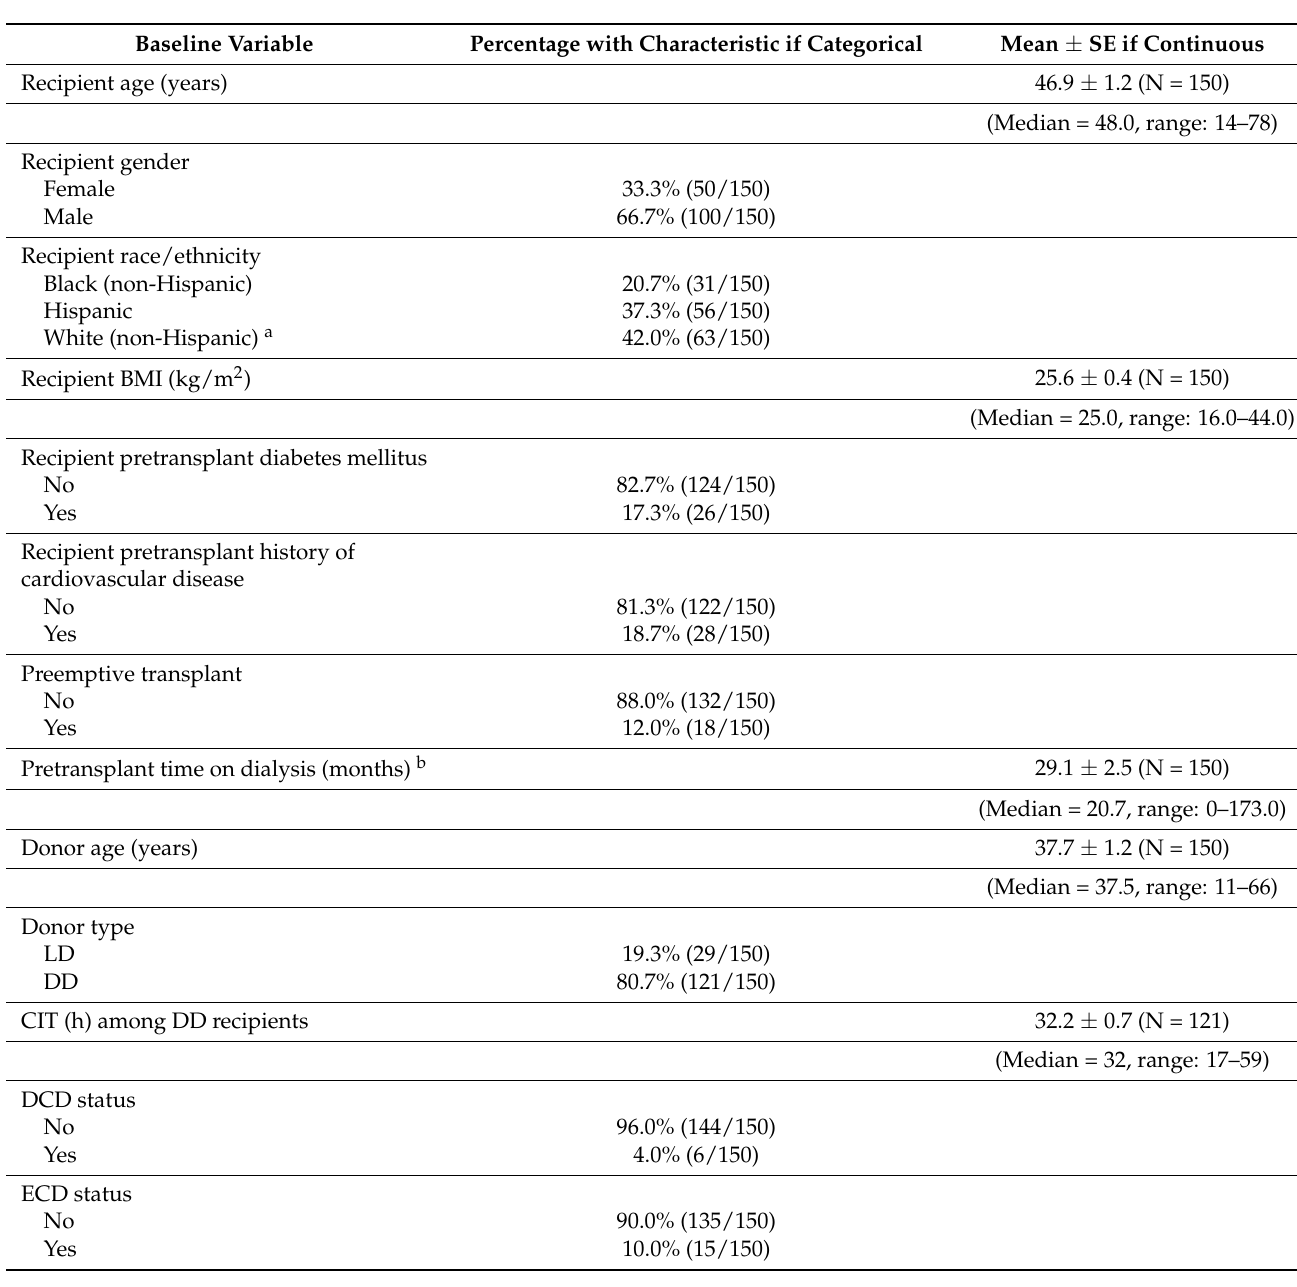
Table 1. Distributions of selected baseline variables (N =